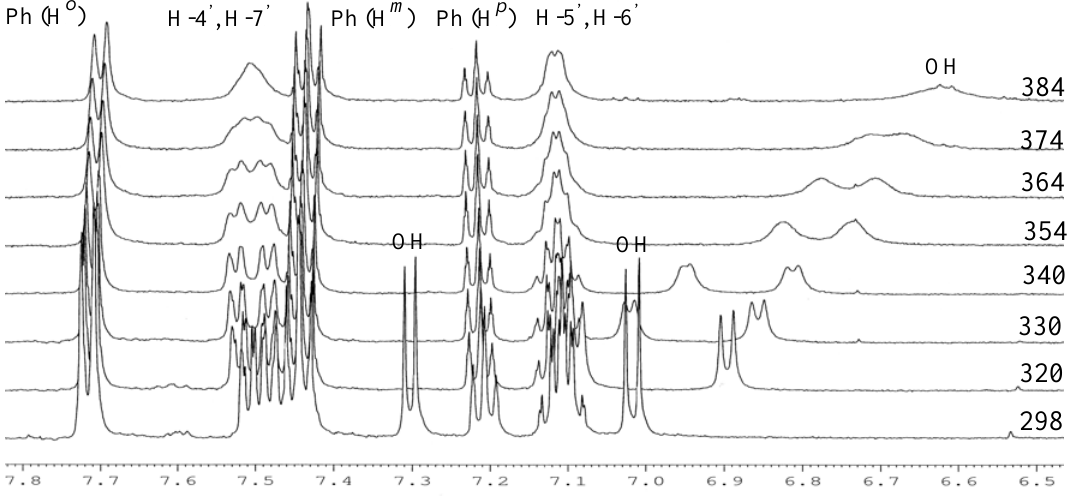
Figure 2. Variable-temperature 500 MHz in DMSO-d B 6 B